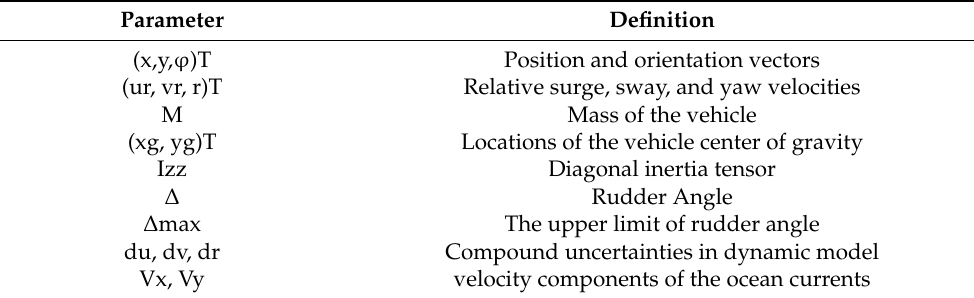
Table 2. Parameters of the AUV